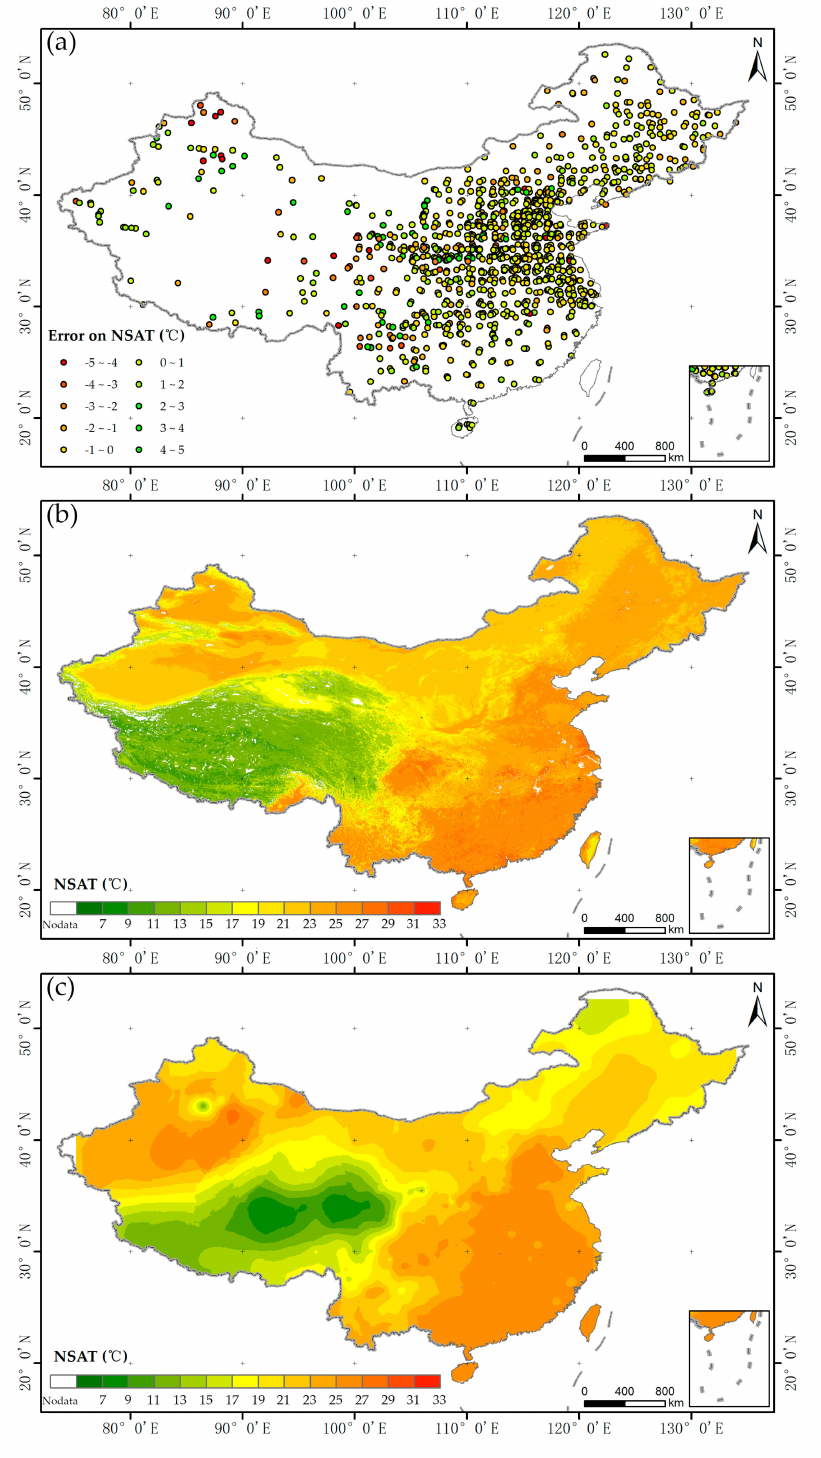
Figure 3. ( a ) The regression residual derived from GWR model in June 2010, ( b ) NSAT map derived using the GWR model in June 2010, ( c ) NSAT map derived using the Kriging model in June